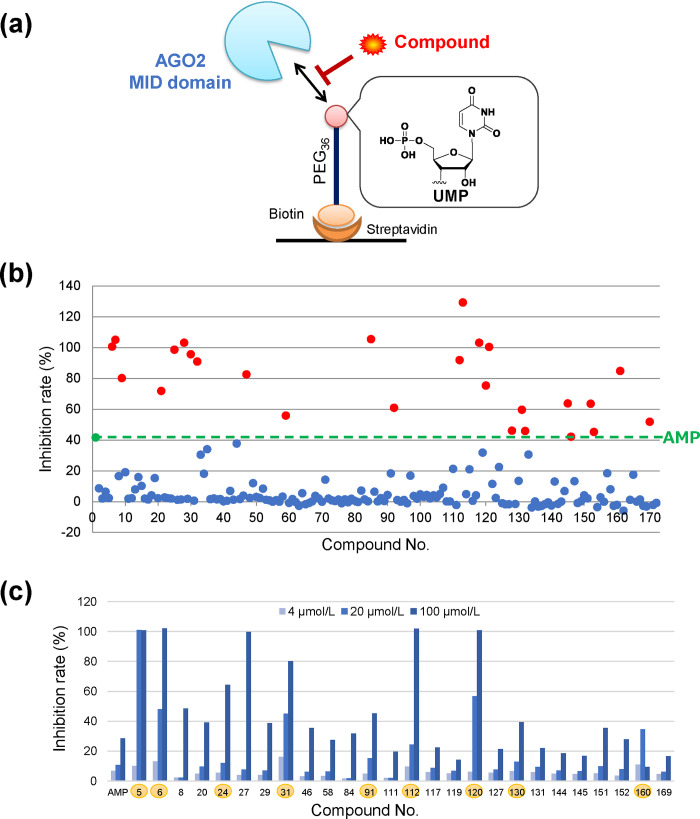
SPR screening focusing on the binding between the 5’ terminus of RNA and MID domain.(a) Experimental system of SPR screening. (b) Inhibition rate of 171 compounds obtained by in silico screening at 200 μmol/L. Green line indicates the criteria (inhibition rate of AMP). Red points indicate the “hit” candidates of the dose-response analysis. Blue points indicate unselected compounds. (c) Inhibition rate of 26 compounds at three concentrations. Highlighted compounds indicate the “hit” compounds from this screening. AGO, Argonaute; AMP, adenosine monophosphate; MID, middle; PEG, polyethylene glycol; SPR, surface plasmon resonance; UMP, uridine monophosphate.